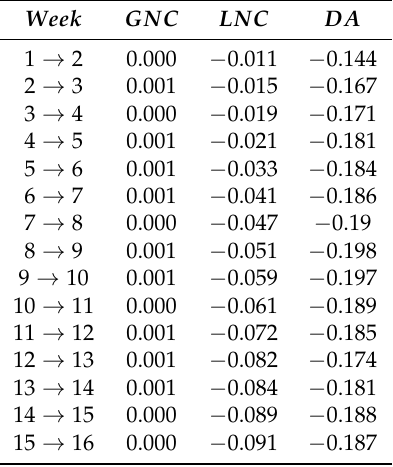
Table 4. Clustering based sampling and dynamic